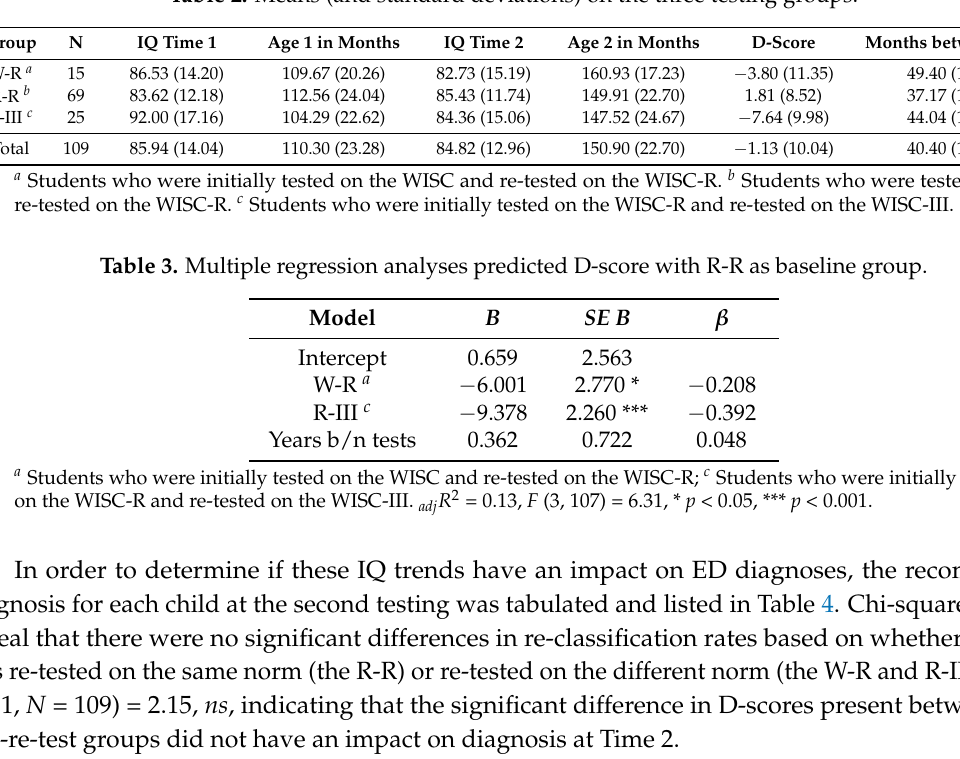
Table 2. Means (and standard deviations) on the three testing groups.